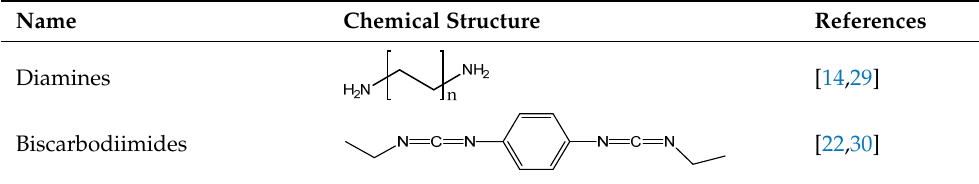
Table 2. Commercially used crosslinkers for HA’s carboxyl groups modifications.